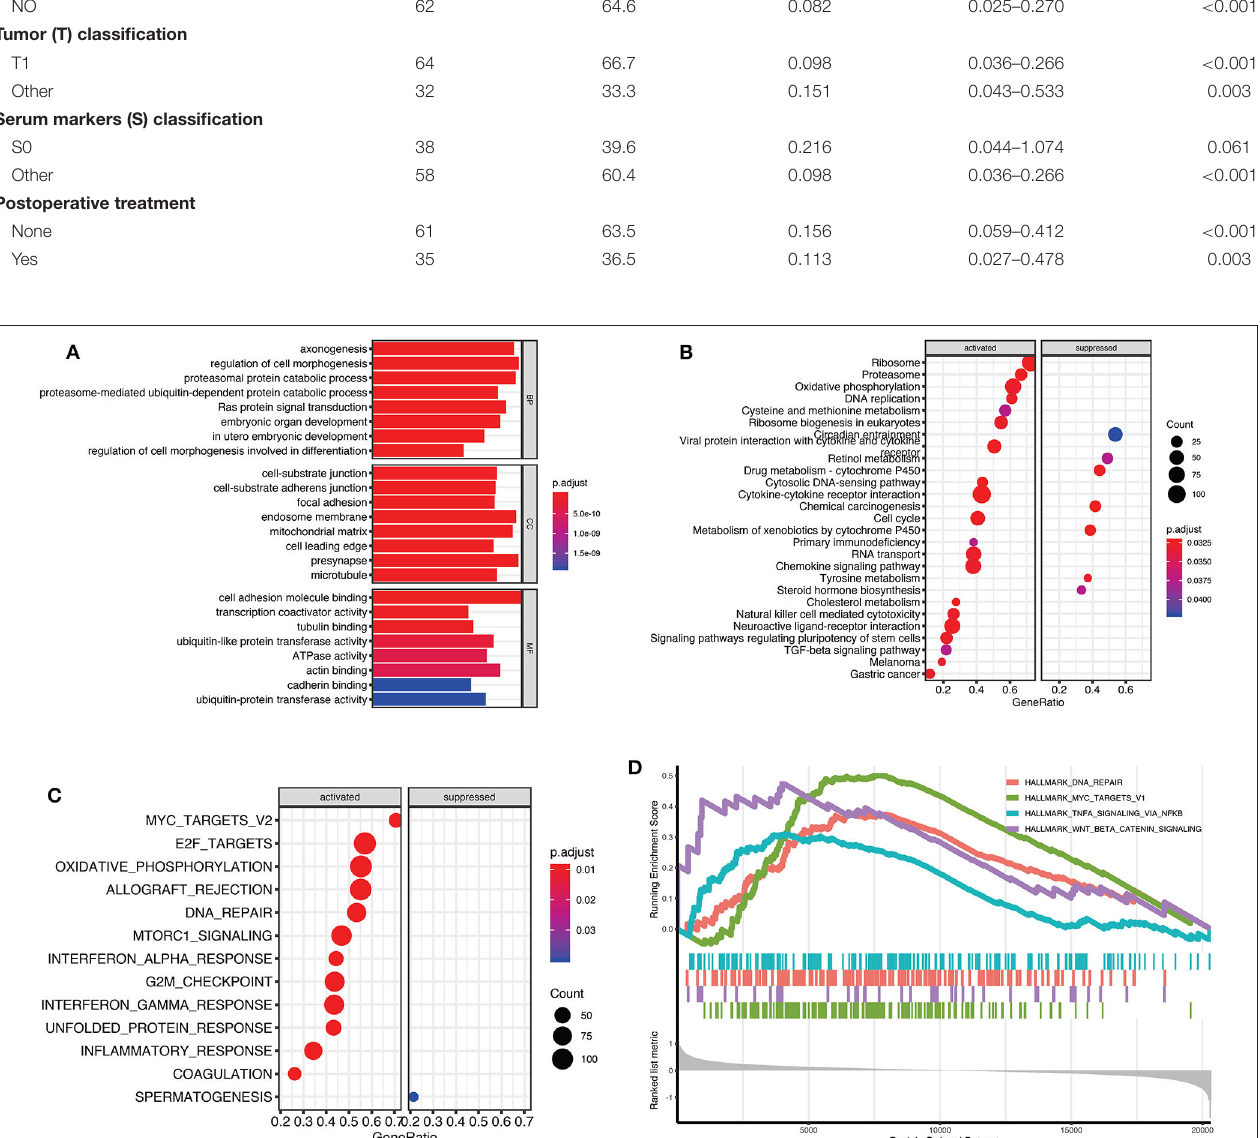
FIGURE 5 | Gene Set Enrichment Analysis (GSEA) for Gene Ontology (GO) and Kyoto Encyclopedia of Genes and Genomes (KEGG) enrichment between high-risk and low-risk groups. (A) The top terms of molecular functions (MF), biological processes (BP), and cellular components (CC) in GO enrichment analysis. (B) GSEA-based KEGG analysis revealed the 27 significantly enriched pathways. (C) Activated and suppressed enrichment hallmarks terms in high-risk patients. (D) The visualization of some important enrichment hallmark terms.